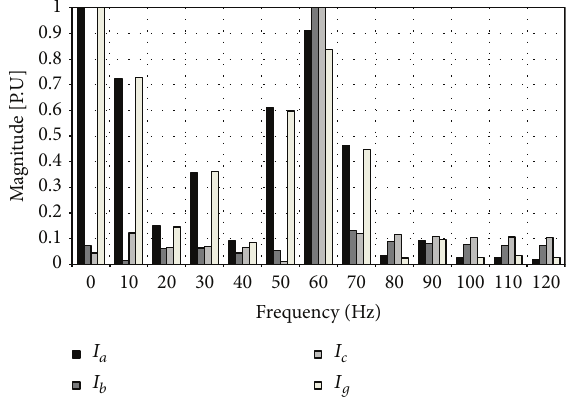
Figure 8: Failure voltages: phase A to ground.